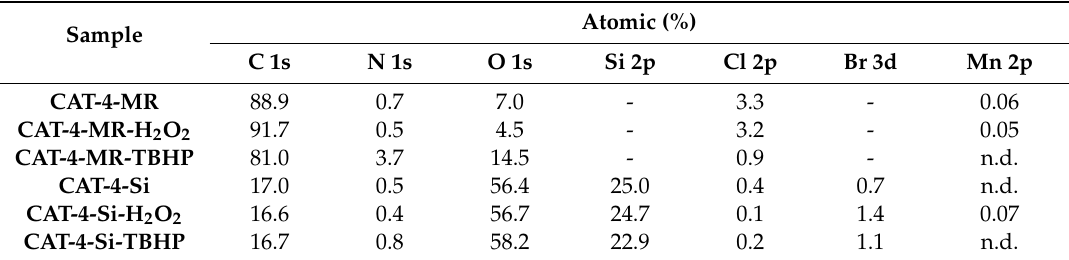
the oxidant. ( a ) 250 × , ( b ) 25,000 × , ( c ) 40,000 × , ( d ) 100,000 × . Table 4. Comparison of the surface atomic percentages obtained by XPS for CAT-4-MR and CAT-4-